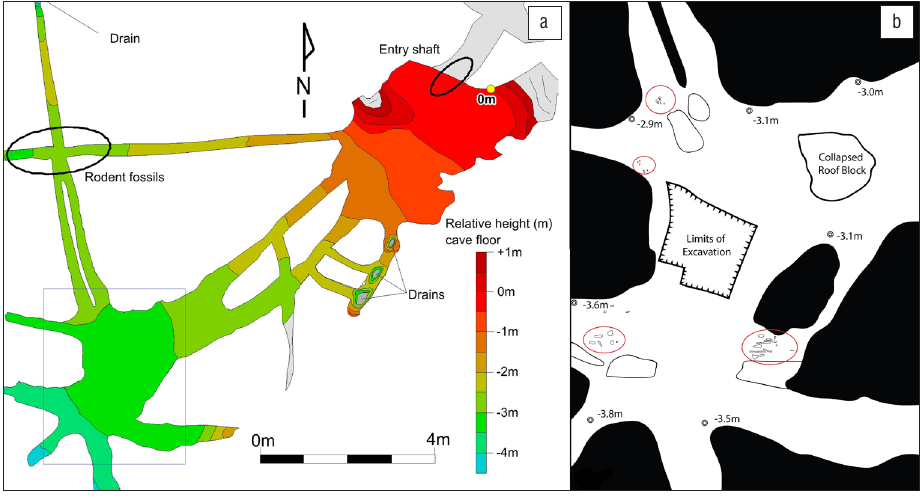
Schematic of the Rising Star (Dinaledi) Chamber. Figure 1a shows the overall layout of the Dinaledi Chamber, side passages and crawls, and the relative drop in height from the entry shaft and the limits of accessibility chamber, with significant concentrations of hominin bone discovered on the surface of the floor outlined in